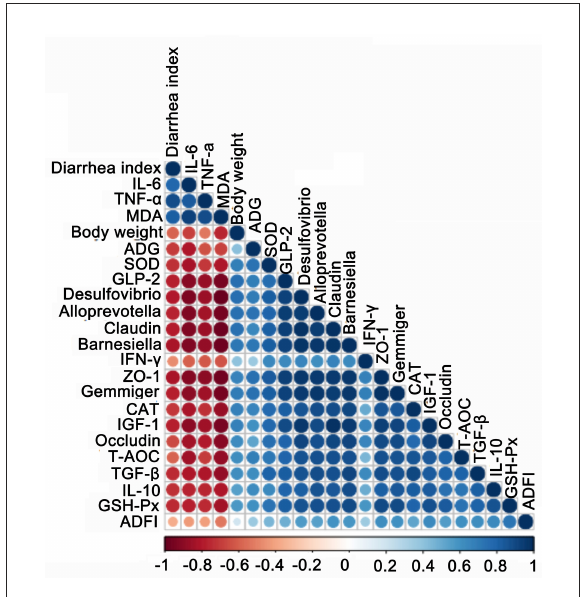
FIGURE7 Correlation analysis among biochemical indexes, growth performance, gut barrier, and microbes. The color of the circle represents a positive or negative correlation, and the size of the circle represents the strength of the correlation (larger circle = stronger